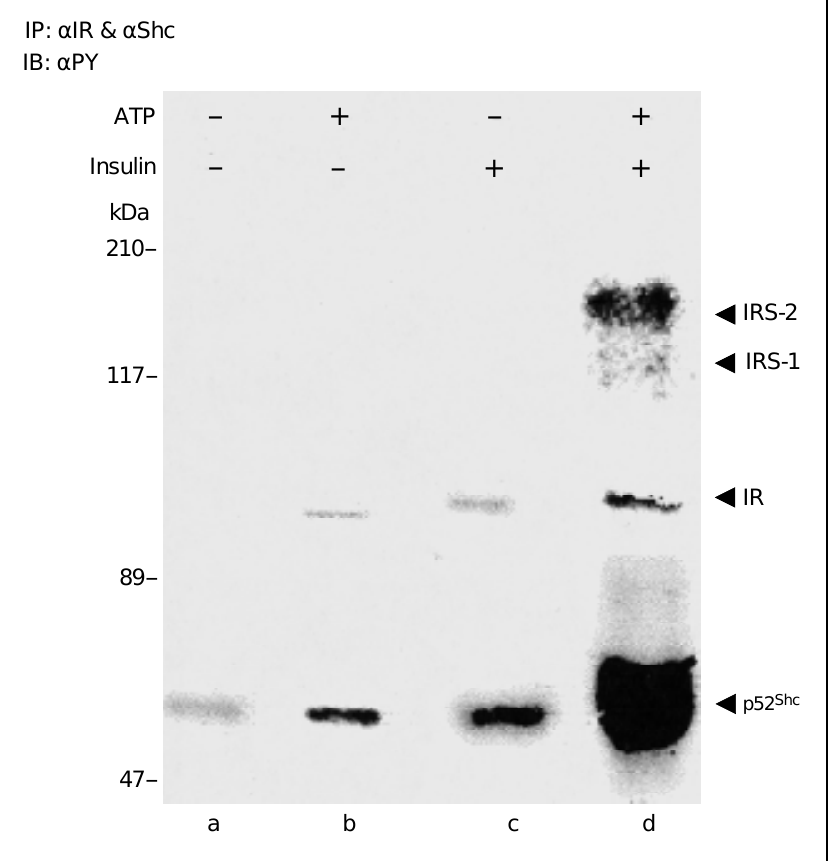
Figure 1 - IR tyrosine kinase activity measured by autophosphorylation with immunopurified complex. The rats were anesthetized and the abdominal wall was incised to expose the vis- cera. Saline or 6 pg of insulin (as indicated